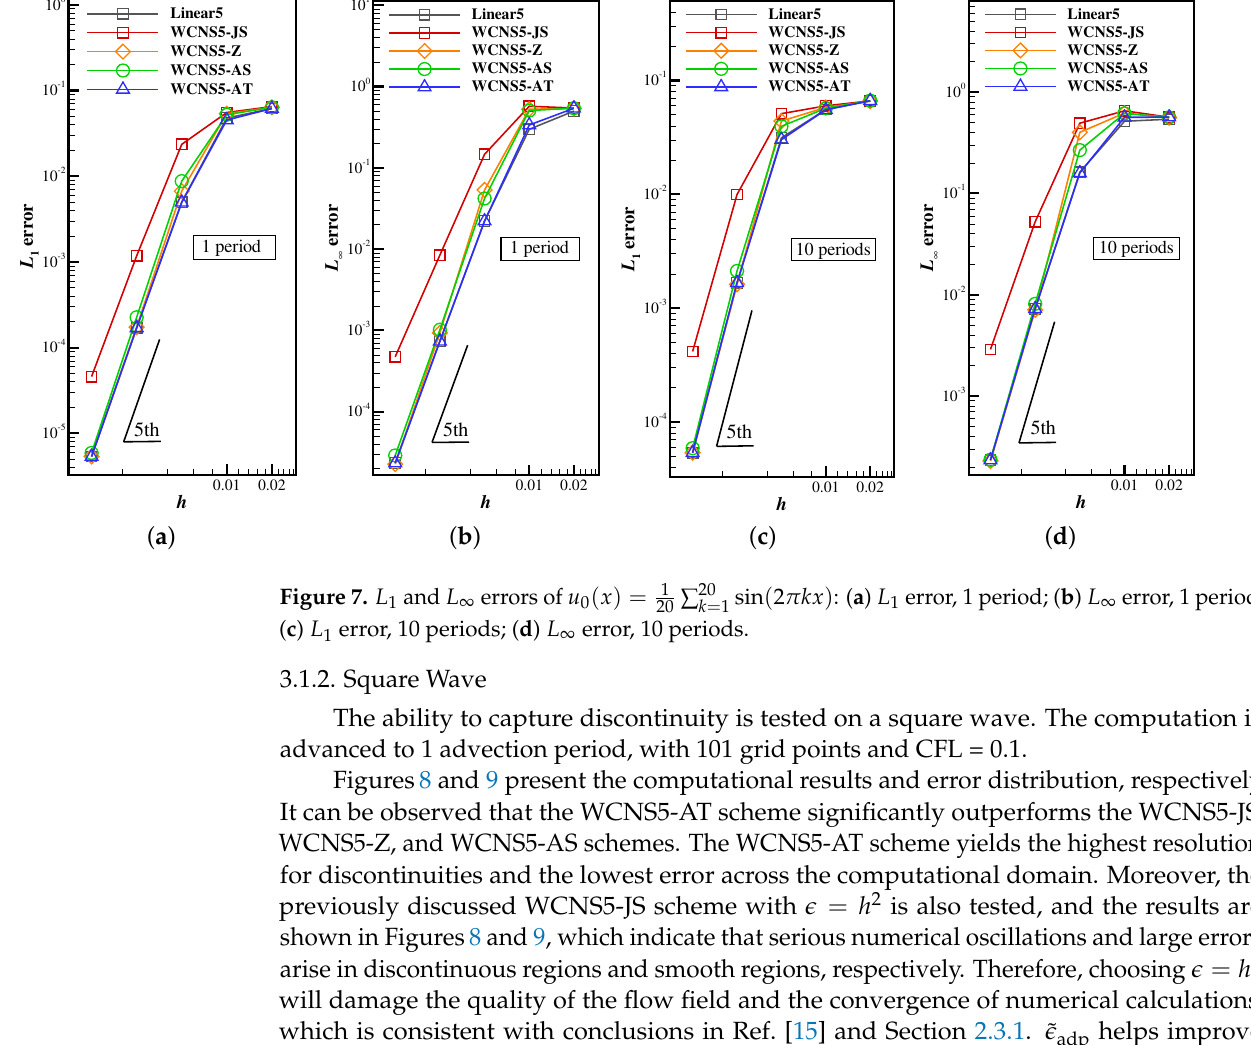
Figure 7. L 1 and L ∞ errors of u 0 ( x ) = 1 ( c ) L 1 error, 10 periods; ( d ) L ∞ error, 10